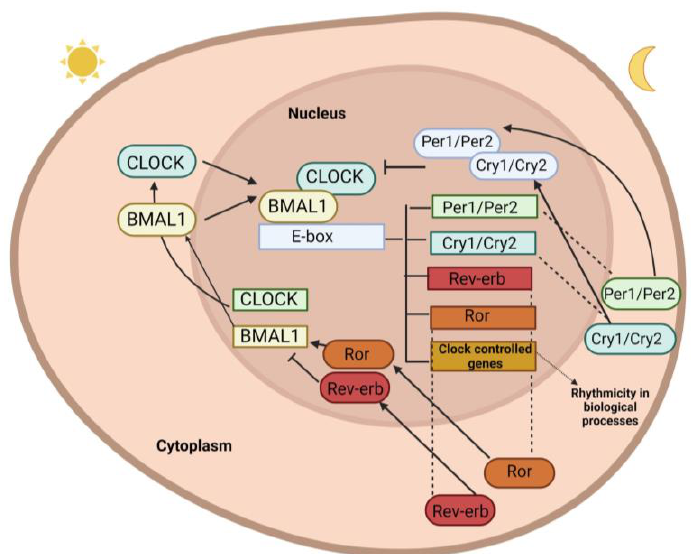
Figure 1. The molecular circadian clock mechanism. On a molecular level, the circadian clock is regulated by transcription factors that, upon excessive rising, inhibit their own expression through transcriptional–translational feedback loops. Specifically, the transcription activators BMAL1 and CLOCK heterodimerize in the cytoplasm and translocate to the nucleus to bind to the E-box pro- moter region of the genes Per1/2 (period) and Cry1/2 (cryptochrome), driving their transcription and translation. The translated proteins PER1/2 and CRY1/2 then heterodimerize and initiate inhibitory feedback of CLOCK and BMAL1, thus consequently inhibiting their own expression due to CLOCK and BMAL1 repression. Because ubiquitin degrades the PER-CRY dimer, the cycle begins again through the disinhibition of BMAL1:CLOCK . Additionally, the transcription factor REV-ERB sup- presses BMAL1 , and ROR (retinoic acid-related orphan receptor) activates BMAL1 . This action gen- erates a negative feedback loop in which gene expression, hormonal secretion, and protein levels oscillate on an ~24 h basis.